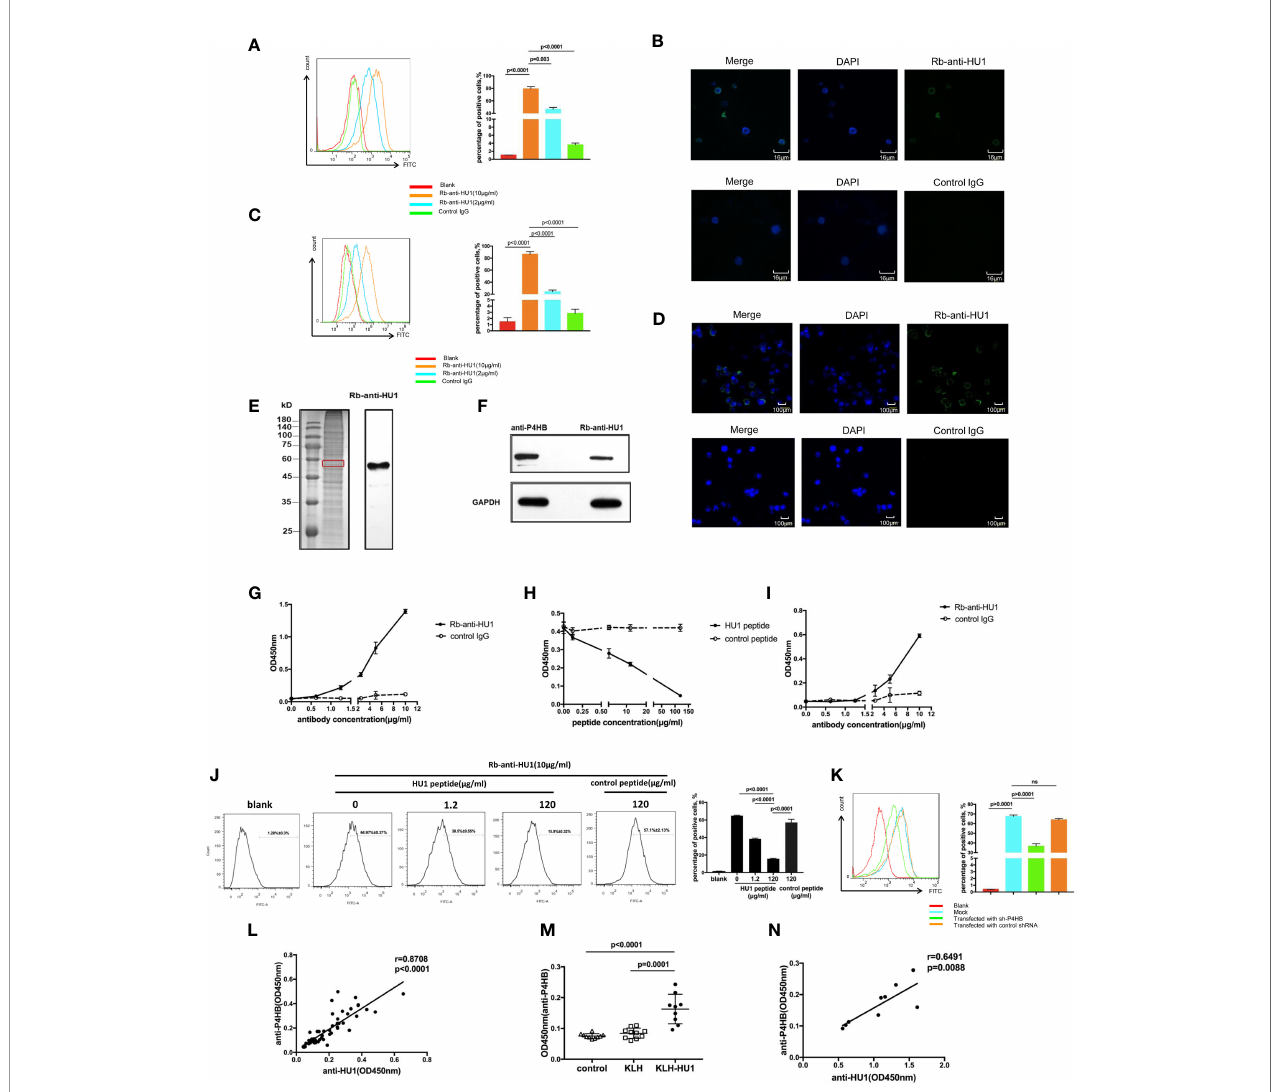
FIGURE 4 | The protein disul fi de isomerase, P4HB, as a target autoantigen. (A) Binding of Rb-anti-HU1 to mouse primary kidney cells was measured by fl ow cytometry. Live mouse primary kidney cells were stained with Rb-anti-HU1 (0 m g/ml-red, 2 m g/ml-blue, 10 m g/ml-orange), and then detected with DyLight ™ 488 labeled donkey anti- rabbit IgG. Flow cytometry analysis was performed on FACSCalibur (Becton Dickinson). Data were processed using FlowJo software. Data are representative of three independent experiments and are shown as mean ± SD. (B) Confocal microscopy showed that Rb-anti-HU1 (10 m g/ml) recognizes a member antigen on mouse primary kidney cells. (C) Binding of Rb-anti-HU1 to HEK293T cells was measured by fl ow cytometry. HEK293T cells were stained with Rb-anti-HU1 (0 m g/ml-red, 2 m g/ml-blue, 10 m g/ml-orange), and then detected with DyLight ™ 488 labeled donkey anti-rabbit IgG. Flow cytometry analysis was performed on. FACSCalibur (Becton Dickinson) and data were processed using FlowJo software. Data are representative of three independent experiments and are shown as mean ± SD. (D) Confocal microscopy showed that Rb-anti-HU1 (10 m g/ml) recognizes a member antigen on HEK293T cells. (E) HEK293T cells total proteins were extracted and detected by western blot using Rb- anti-HU1 antibody. The band labeled in the red square indicates the speci fi c band recognized by Rb-anti-HU1. Data represent one of three independent experiments. (F) Bands recognized by Rb-anti-HU1 and Mo-anti-P4HB were detected from total proteins of HEK293T cells by western blot. The interaction between Rb-anti-HU1 and human P4HB (G) and mouse P4HB (I) was measured by ELISA. Data are shown as the mean ± SD. (H) Speci fi c binding of Rb-anti-HU1 to human P4HB was blocked by HU1 peptide in a concentration-dependent manner. Data are shown as mean ± SD. (J) Speci fi c binding of Rb-anti-HU1 to native P4HB on mouse primary kidney cell surface was blocked by HU1 peptide in a concentration-dependent manner. Data are representative of three independent experiments and are shown as mean ± SD. (K) P4HB expression was knocked down by a speci fi c small hairpin RNA(sh-P4HB). Flow cytometry was then performed to detected the speci fi c binding of Rb-anti-HU1 (5 m g/ml) to P4HB on the surface of HEK293T cells by fl ow cytometry. Data are shown as mean ± SD. (L) Correlation between the anti-HU1 antibody and anti-P4HB antibody in sera from patients with SLE. Each point represents a measurement for an individual patient (n = 62). (M) Detection of anti-P4HB titer in the sera of mice immunized with KLH-HU1 and control groups by ELISA at week 23 post-pristane induction (control, n = 10; KLH, n = 10; KLH-HU1, n = 9). (N) Correlation between anti- HU1 antibody and anti-P4HB antibody in sera from mice immunized with KLH-HU1 (n = 9). Data are presented as means ± SD. The differences between two groups were statistically analyzed with two-tailed unpair Student ’ s t test using GraphPad Prism 7 software. The correlation between two indicators were statistically analyzed with correlation analysis using GraphPad Prism 7 software. P >0.05 was considered nonsigni fi